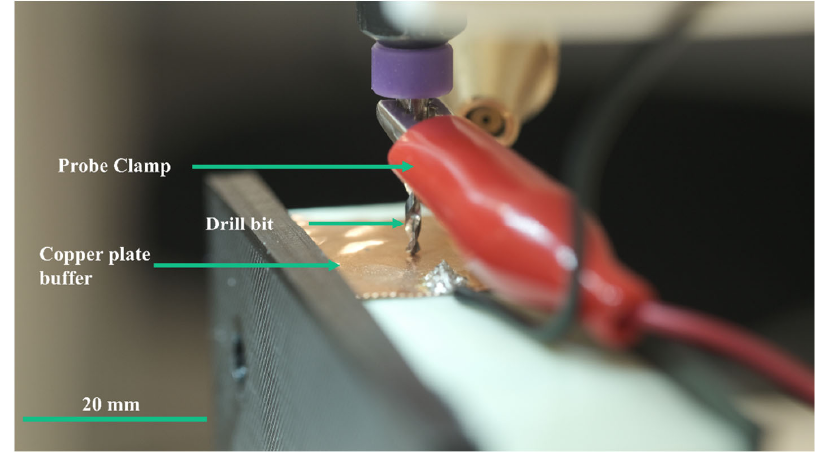
Figure 4. Probing functionality for accurate zero ‐ point detection.